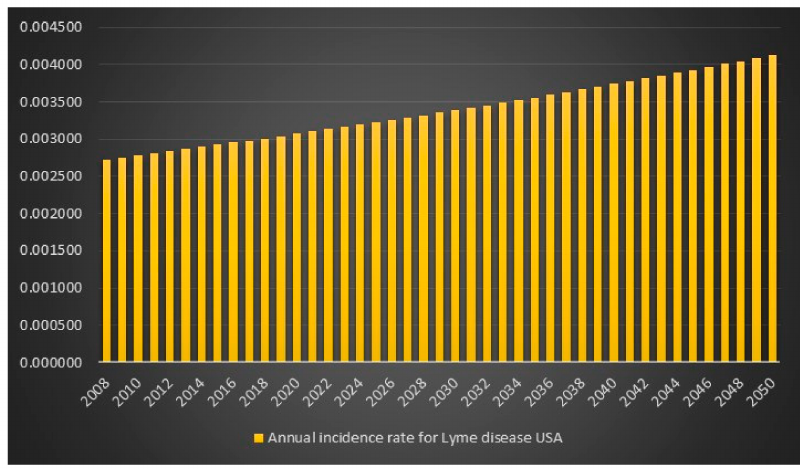
Figure 10. Annual incidence rate of Lyme disease in the USA between the years 2008 to 2050.